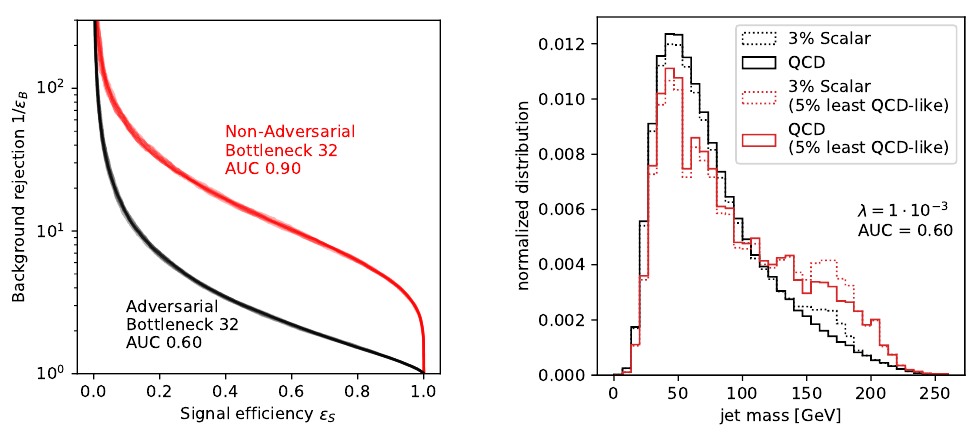
Figure 9: Left: ROC curves for the image-based autoencoders with and without ad- versary. Right: jet mass distributions from the adversarial autoencoder trained on pure